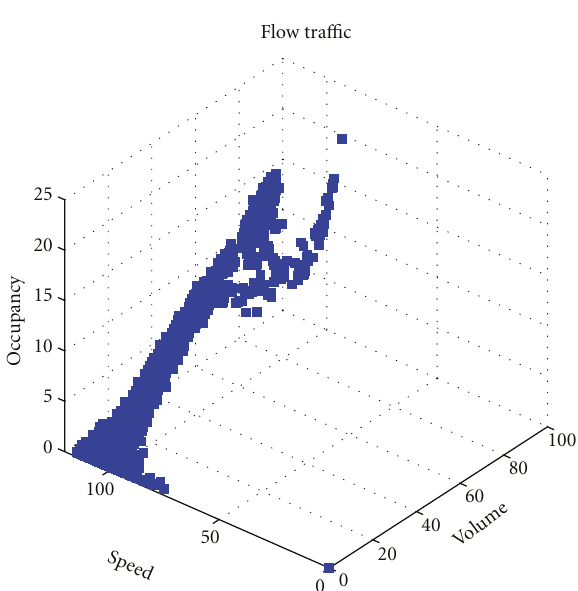
Figure 6: An example simulator data for Dense tra ffi c.